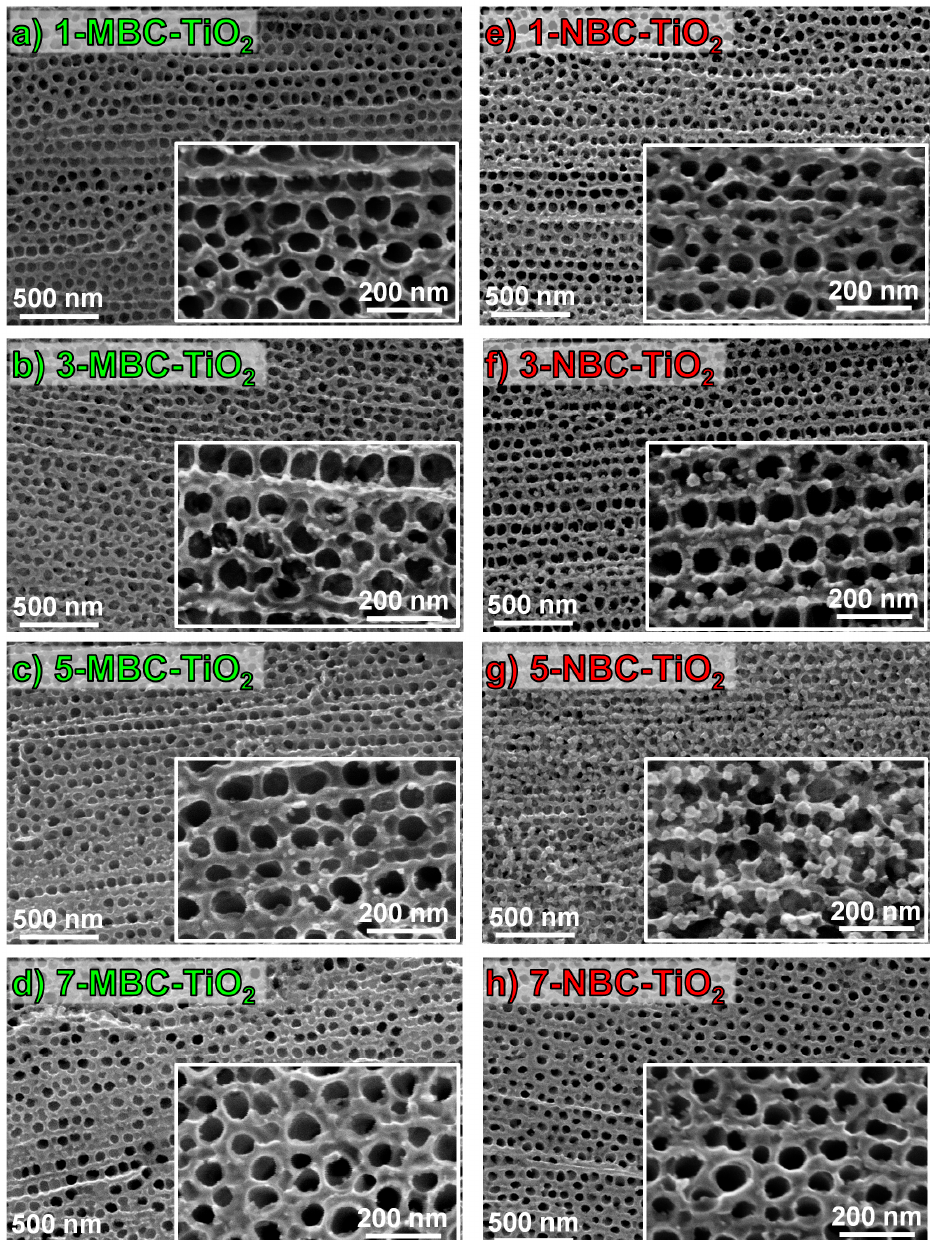
Figure 4. SEM top-view images of the samples obtained by depositing microalgae- ( a – d ) and nutshell-derived ( e – h ) BC NPs on the surface of TiO 2 nanotube arrays. Different BC loadings were